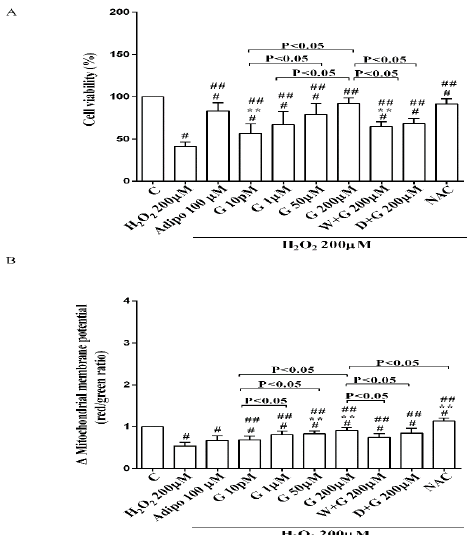
Figure 4. Effects of genistein in pre-adipocytes, cultured in peroxidative condition, on cell viability ( A ) and mitochondrial membrane potential ( B ). N acetyl-cysteine (NAC, 200 µM). Other abbreviations are as in previous figures. Reported data are means ± SD of five independent experiments for each experimental protocol executed in adipocytes taken from each patient. Significance between groups: # p < 0.05 vs. control; ## p < 0.05 vs. H 2 O 2 200 µM; ** p < 0.05 vs. Adipo 100 µ M + H µ M. Short square brackets indicate significance between groups ( p < 0.05).